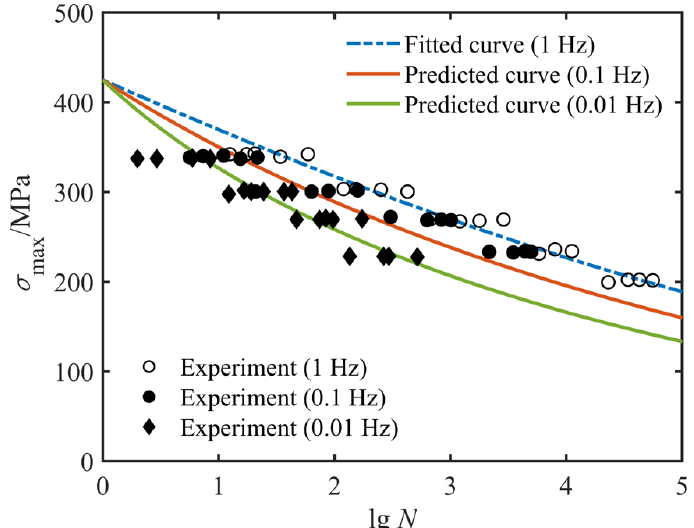
Figure 8. Fitted (1 Hz) and predicted (0.1 Hz and 0.01 Hz) S - N diagrams of cross-ply E-glass/epoxy specimens based on experimental data from Ref. [31].